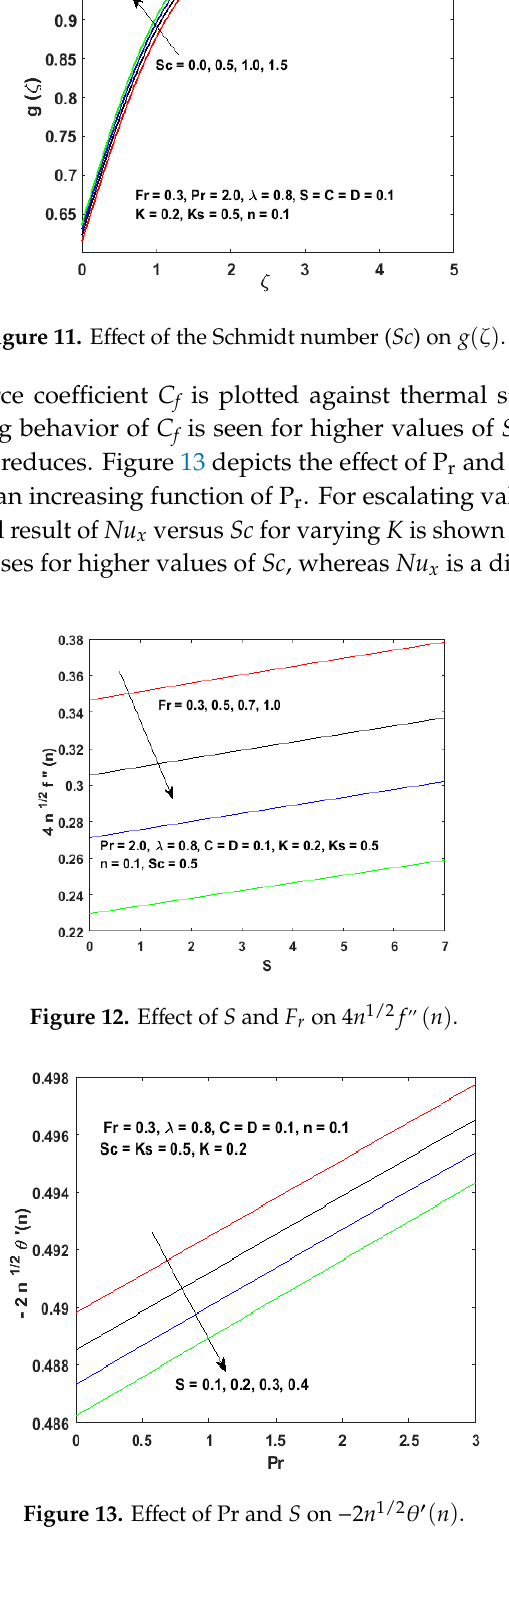
Figure 10. Effect of